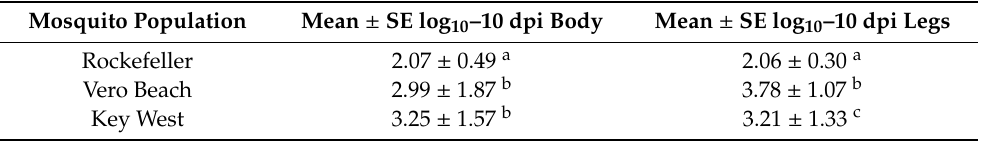
Table 3. Titer for mosquito body and legs at ten days post-exposure to Chikungunya virus for each mosquito population